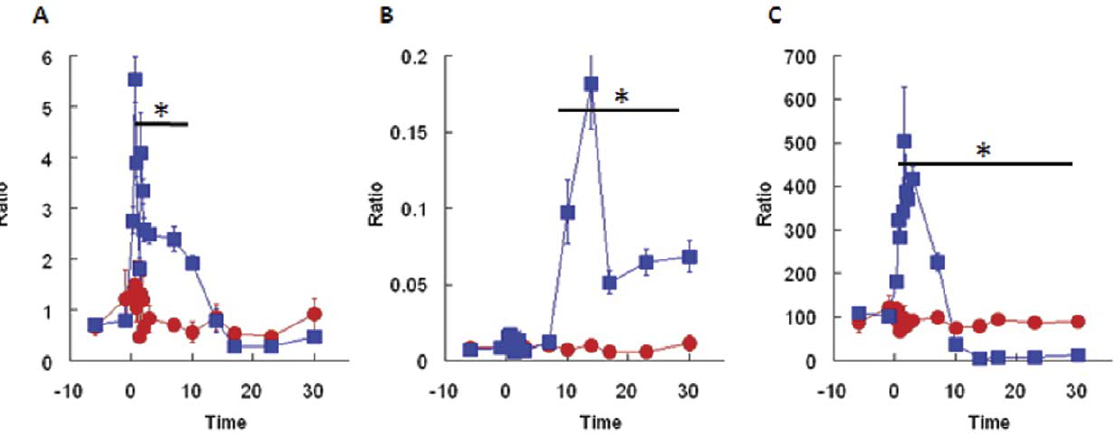
Figure 4. Ratio of hematological parameters. Neutrophil-to-lymphocyte (A), neutrophil-to-platelet (B), and platelet-to-lymphocyte (C) ratios were calculated for sham-irradiated animals (diamonds, n=4) and for animals irradiated with 1.6–2.0 Gy (squares, n=30). Ratios were calculated for each individual animal and results were pooled together. Asterisks (*) indicate statistically significant difference between groups (Student T-test); bars represent standard errors.